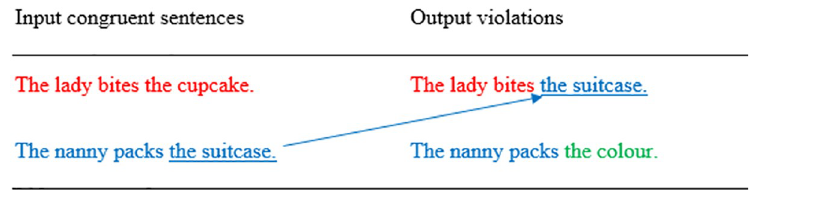
Fig 1. Diagram showing splicing locations for sentences containing semantic violations.